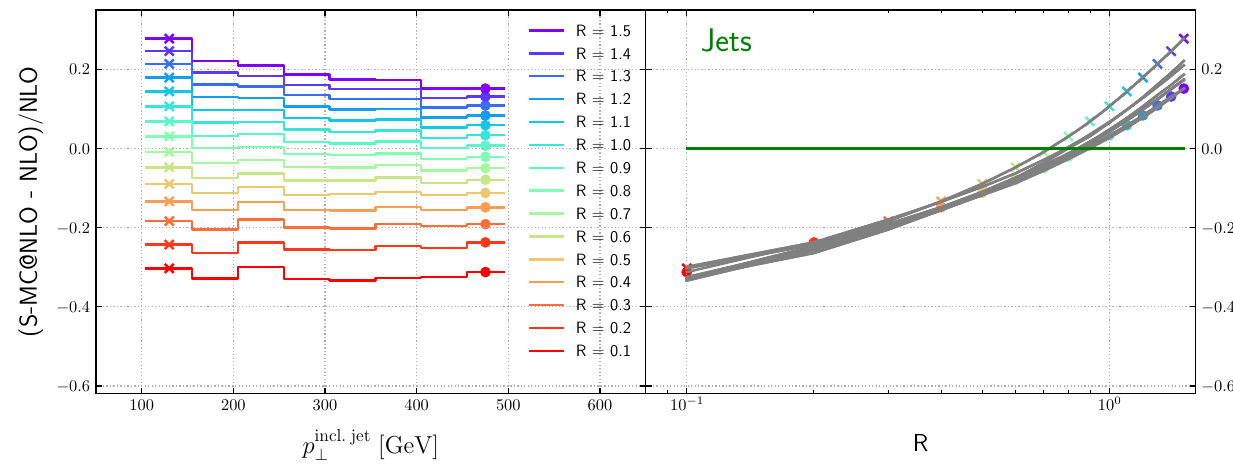
Fig. 16 Relative difference between the NLO-matched prediction and the fixed-order result as a function of the inclusive jet transverse momentum and the jet radius, for dijet production